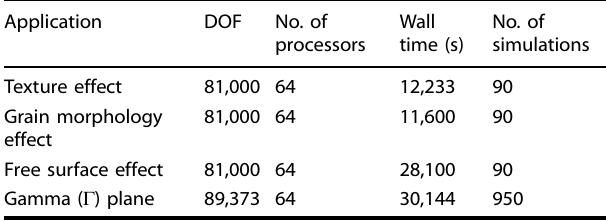
Table 1. A summary of the simulation details and performance of the fi rst four applications presented here including the effects of texture, grain morphology, and free surface on the fatigue crack formation driving force along with the calculation of the Gamma ( Γ )